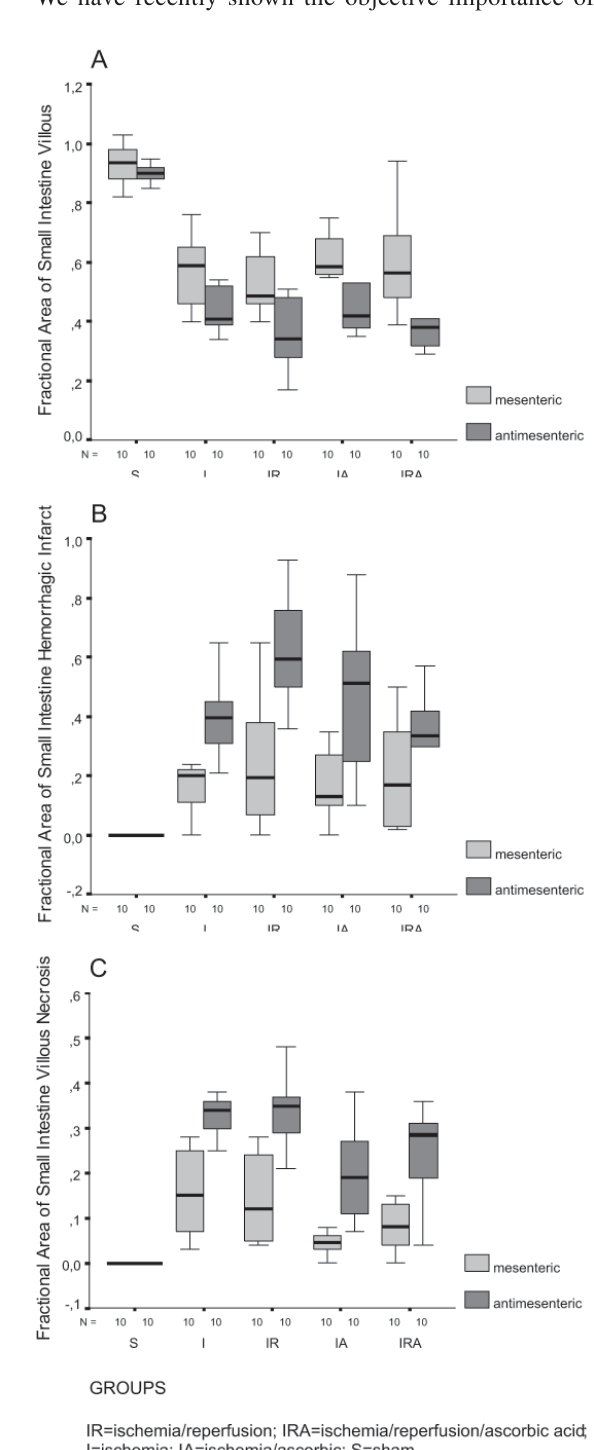
Figure 2. Fractional area of anti mesenteric and mesenteric villous (A), hemorrhagic infarct (B), villous necrosis (C) according to the sham, ischemia, ischemia/reperfusion, ischemia/ascorbic acid and ischemia/reperfusion/ ascorbic